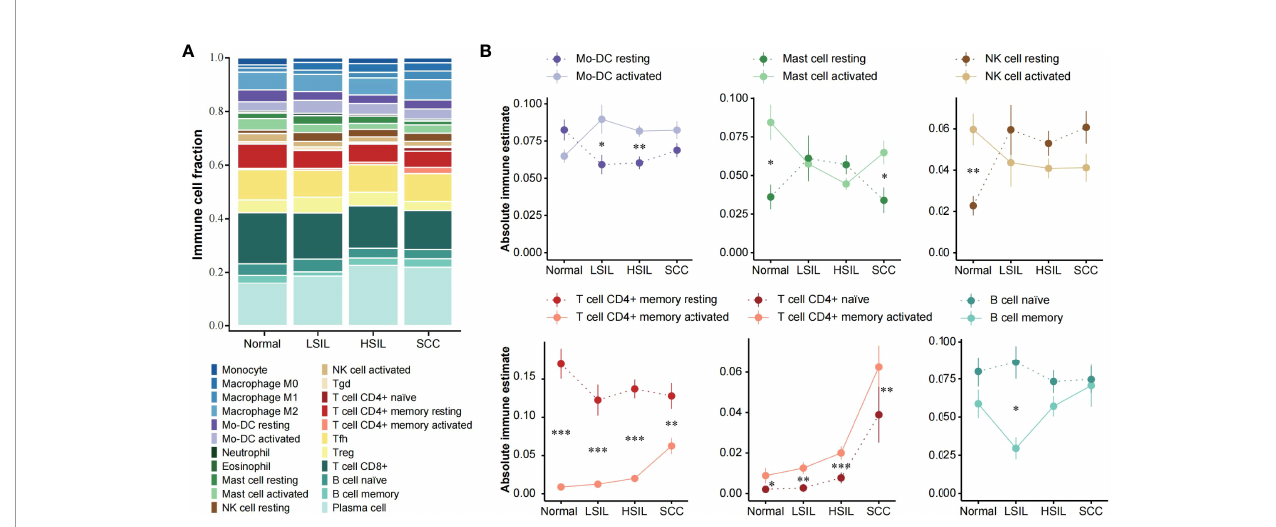
FIGURE 5 | Assessment of local immune status with CIBERSORTX. (A) Stacked bar plot showing the composition of 22 immune cell subsets across different disease stages. The CIBERSORTX-Relative score was used. (B) Line plots showing immune-status shift for Mo-DC, mast cell, NK cell, CD4 + T cell and B cell with development of cervical lesions. Statistical comparisons were performed using Wilcoxon rank-sum test with BH false discovery rate correction. Signi fi cant differences per stage are signed with asterisks. *** p < 0.001, ** p < 0.01, * p < 0.05,